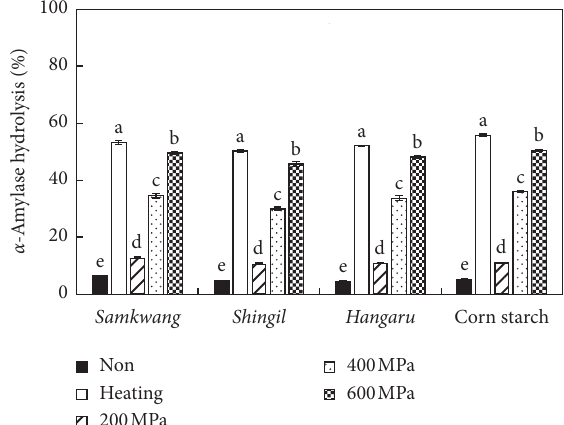
Figure 4: α -Amylase hydrolysis of different rice flours by treatment methods. Values are mean ± SD. n � 3. Different small letters in the same items indicate a significant difference by Duncan’s range test ( p < 0 . 05) according to the treated method.